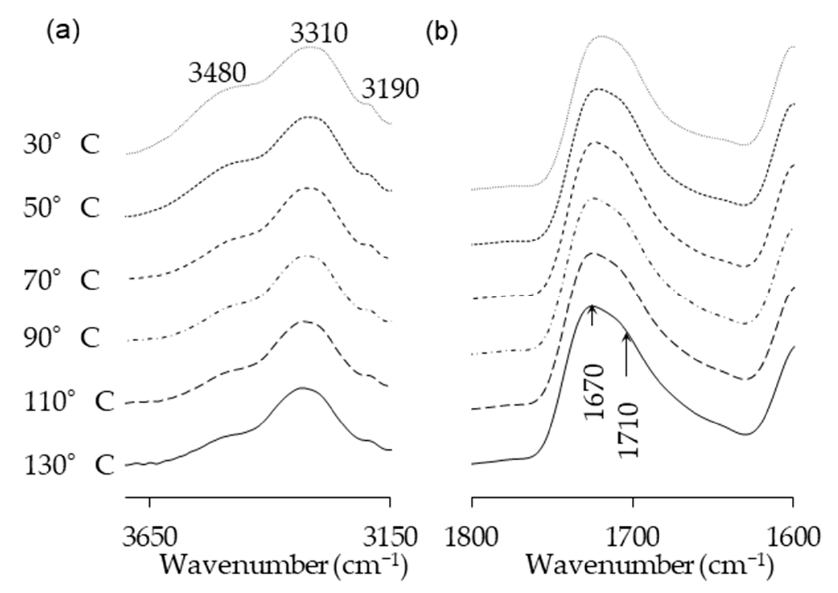
Figure 2. ( a ) N–H stretching and ( b ) amide regions of FT-IR spectra of BIO-PU0.6 at different heating temperatures.